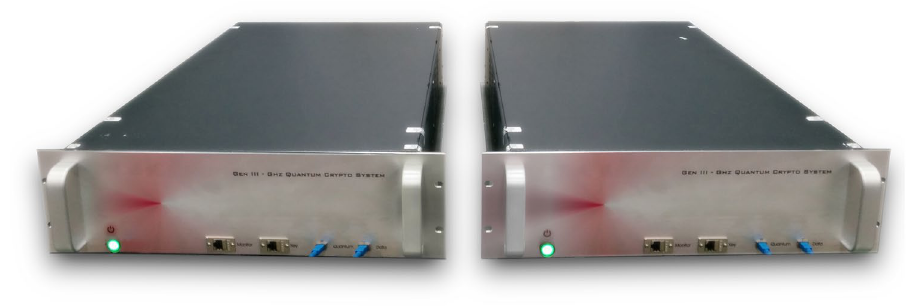
Figure 1. Photograph of the QKD system transmitter and receiver. The units are 19 inch rack sized (3 U high).